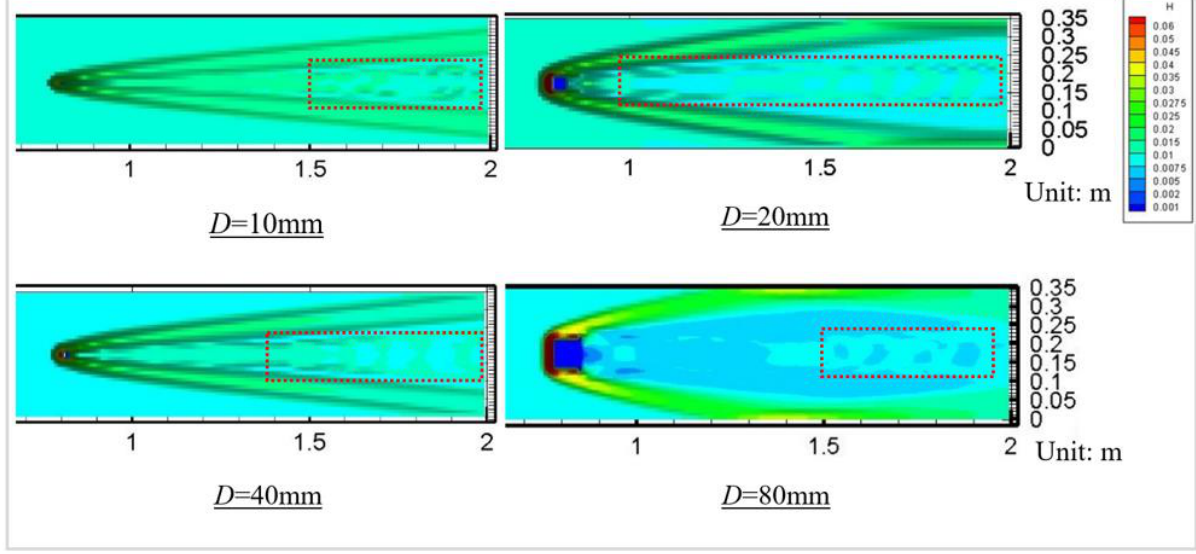
Figure 6. Successive surges in the tail of the fan captured during simulations obtained using the proposed numerical scheme.